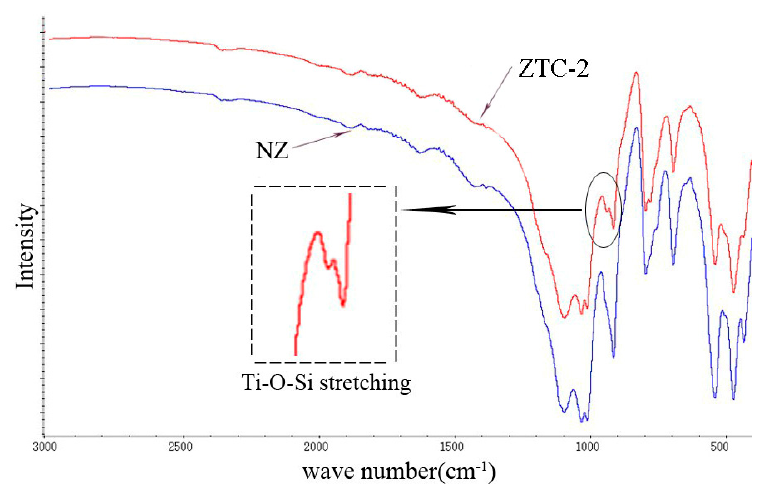
Figure 4. Infrared spectrum of NZ and ZTC-2.